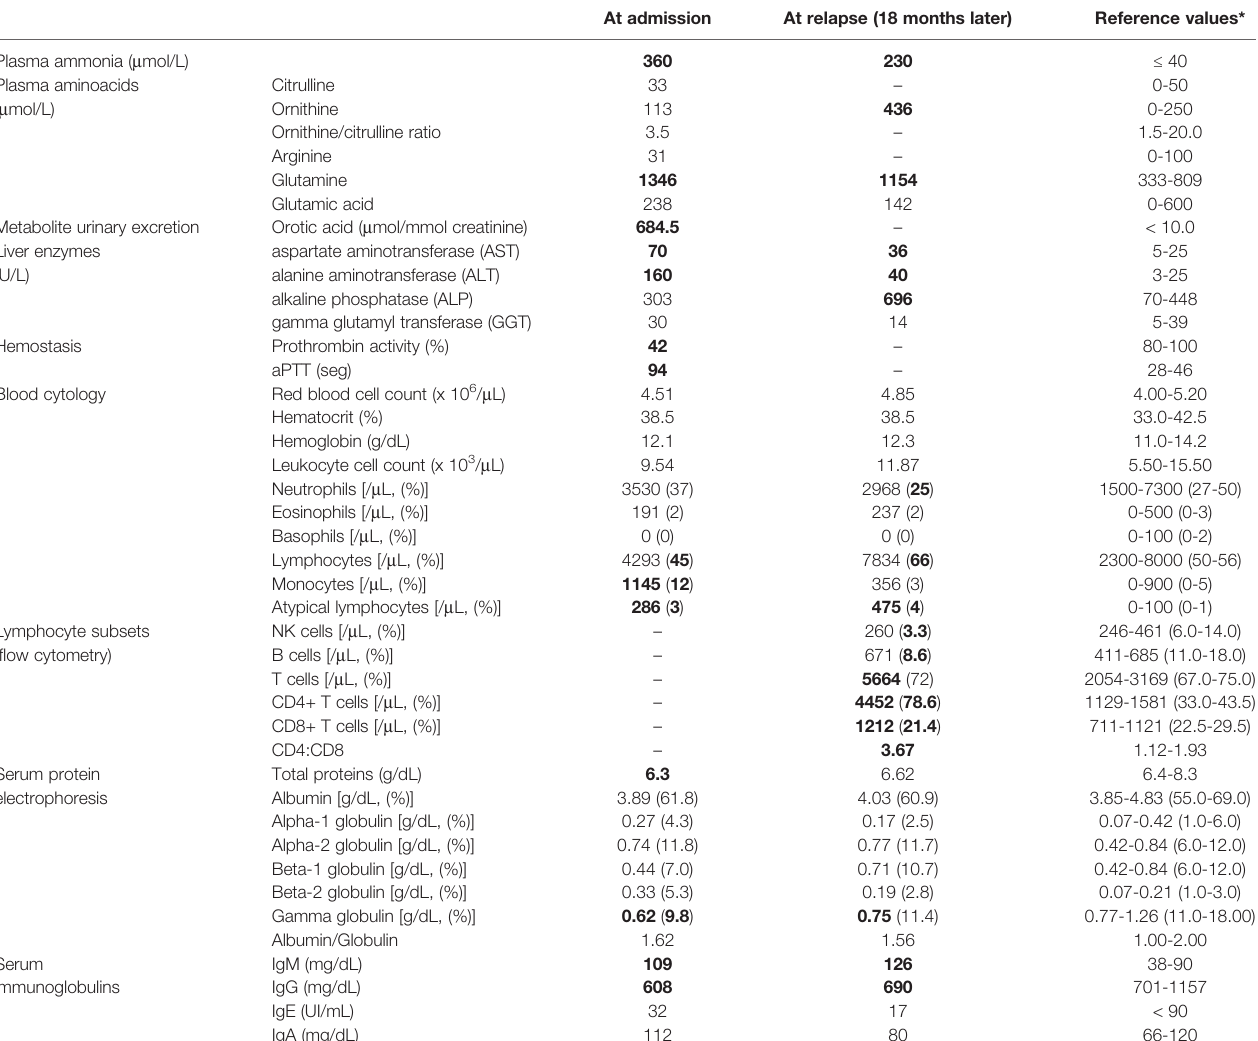
TABLE 1 | Laboratory fi ndings in a patient with HHH syndrome.